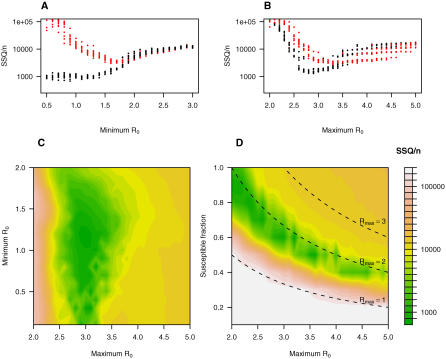
Model Fitting and Comparison by Sum of Squared Deviations(A and B) SSQ/n values for ten runs with each combination of parameter values for two models: model 1 (black), in which transmissibility in the tropics is constant and taken as the north/south maximum; and model 2 (red), in which it is held at the north/south mean. n is the number of cities with observed peaks. The seasonal maximum R
0 (R
0,max) is held constant at 3.0 in (A), and the seasonal minimum R
0 (R
0,min) is held constant at 1.6 (the value giving the minimum SSQ/n for model 2) in (B). In both cases, the fraction of the population initially susceptible was fixed at 0.6.(C and D) SSQ/n values shown are the means of ten runs of the stochastic model for each combination of parameter values. Regions of parameter space supported by the data appear in green (darker green indicates better fit). A constant susceptible fraction of 0.6 is assumed in (C). R
0,min held constant at 1.2 in (D); broken lines indicate regions of the parameter space with constant effective reproduction numbers, Rmax (where Rmax = R0,max× susceptible fraction).